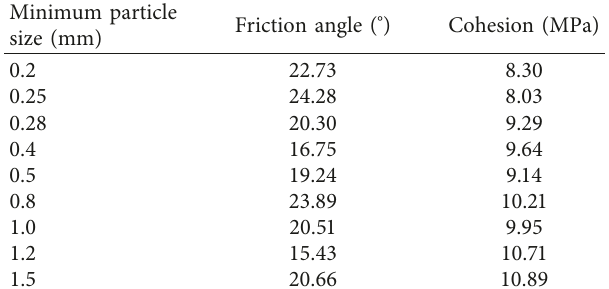
Table 8: Shear strength parameter values of different particle size